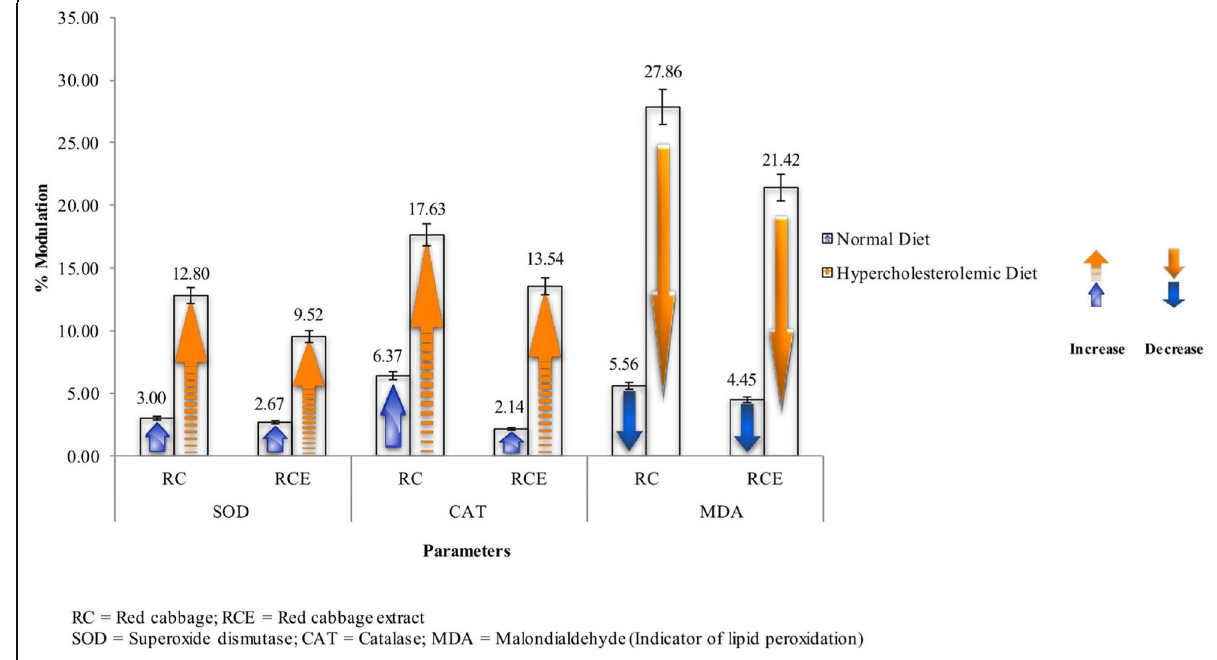
Fig. 1 Percent modulation in serum oxidative stress biomarkers in comparison to